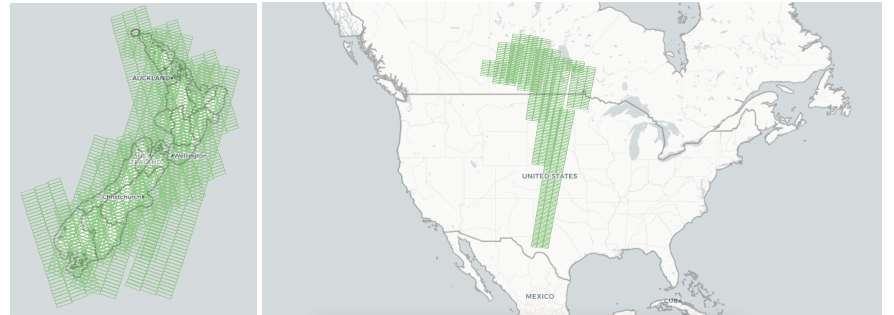
Figure 2. Examples from our global footprint database. ( Left ) Sentinel-1 burst footprints acquired over New Zealand up to 1 June 2022. ( Right ) New, previously unimaged footprints between 24 December 2021 and 1 June 2022 over North America, in response to the Sentinel-1B outage in December 2021.